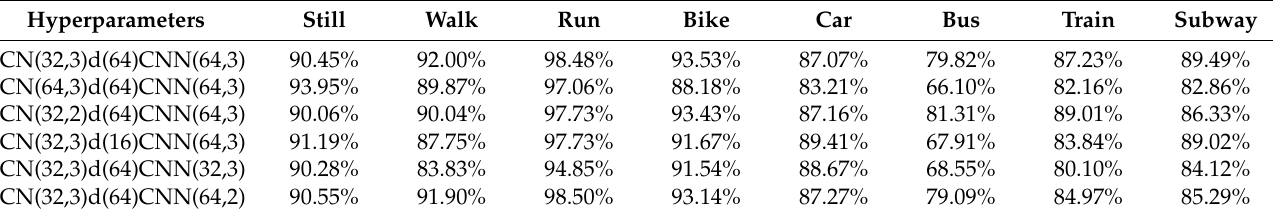
Table 9. Comparison of the precision of different hyperparameters on the HTC dataset.